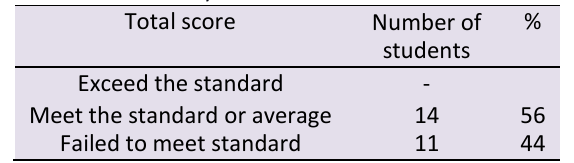
Table 4 . Analysis of Written Communication Skills